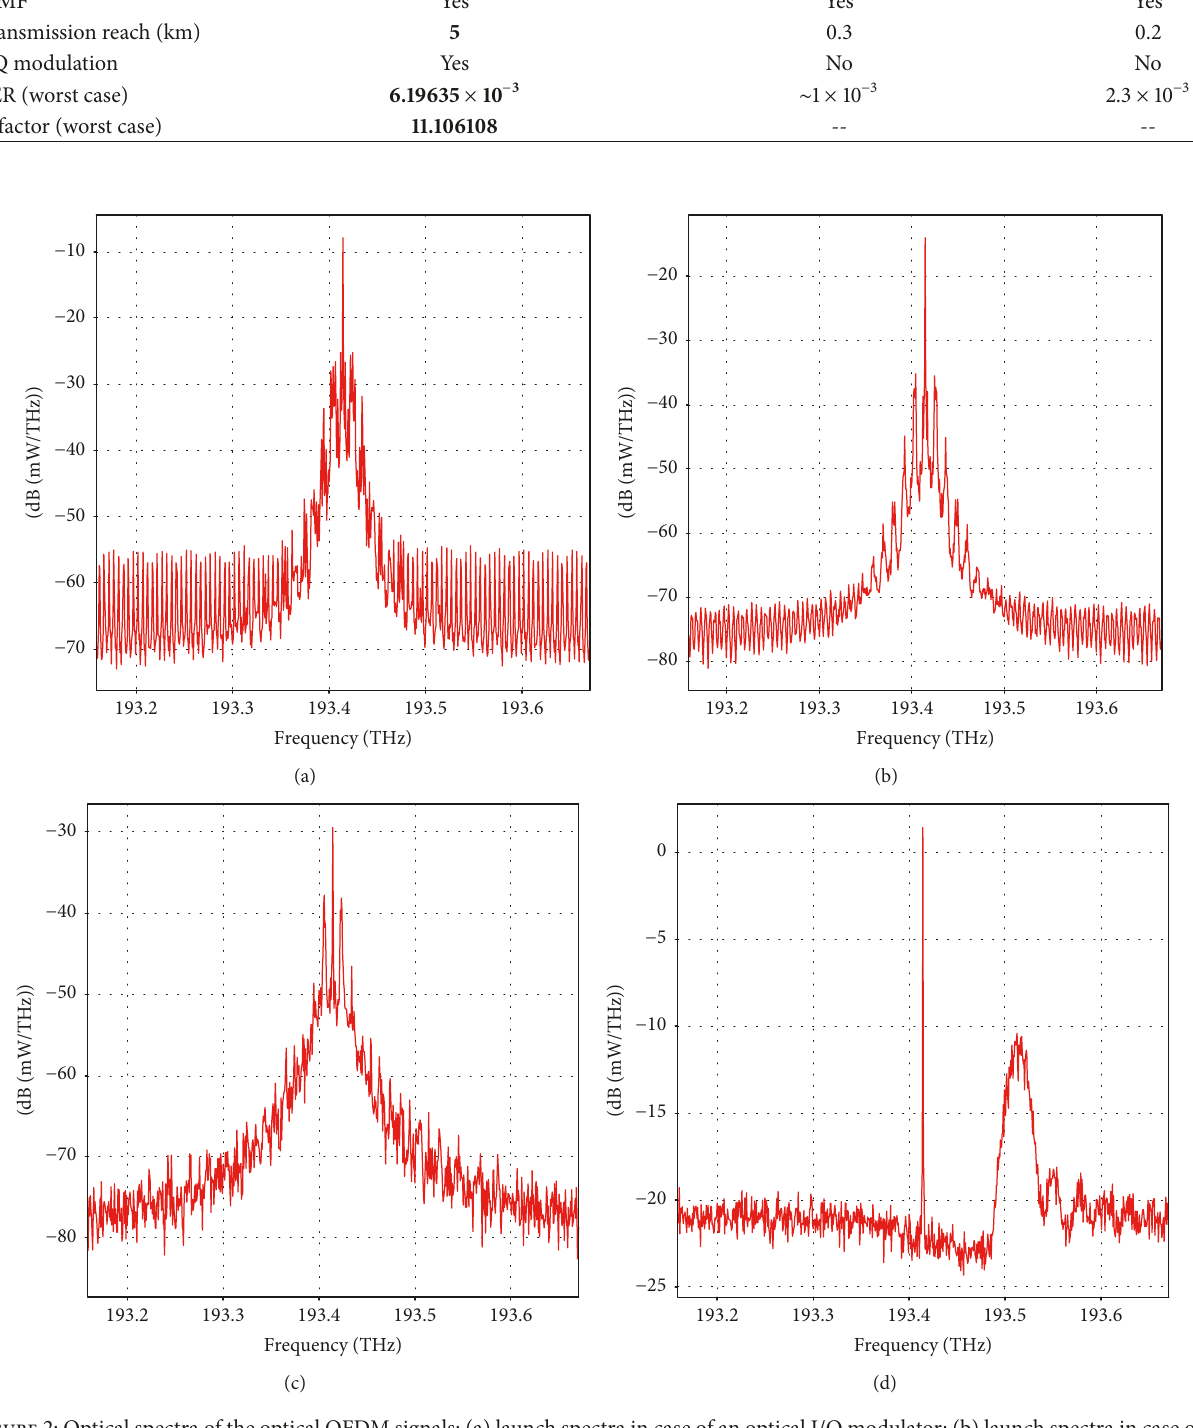
Figure 2: Optical spectra of the optical OFDM signals: (a) launch spectra in case of an optical I/Q modulator; (b) launch spectra in case of a direct modulator; (c) received spectra from the MMF link in case of an optical I/Q modulator; and (d) received spectra from the MMF link in case of a direct